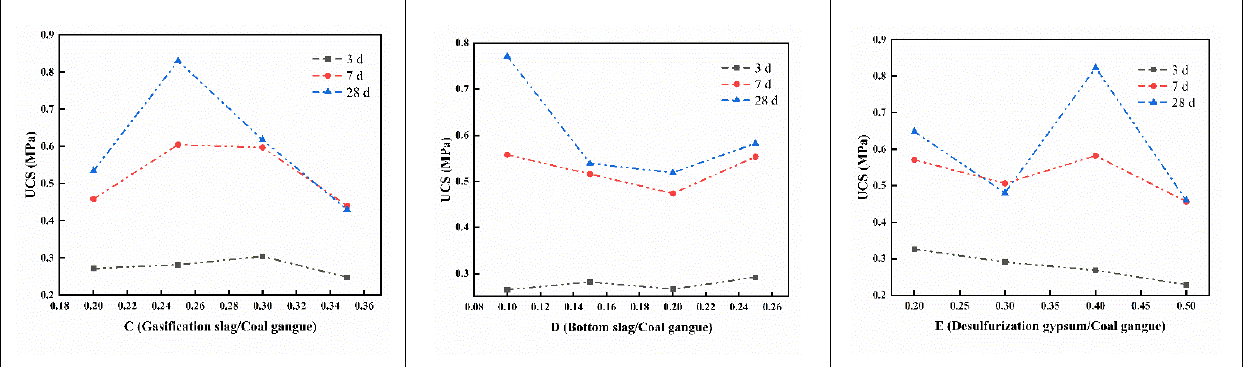
Figure 11. Influence of gasification slag, bottom slag and desulfurized gypsum on strength devel- opment